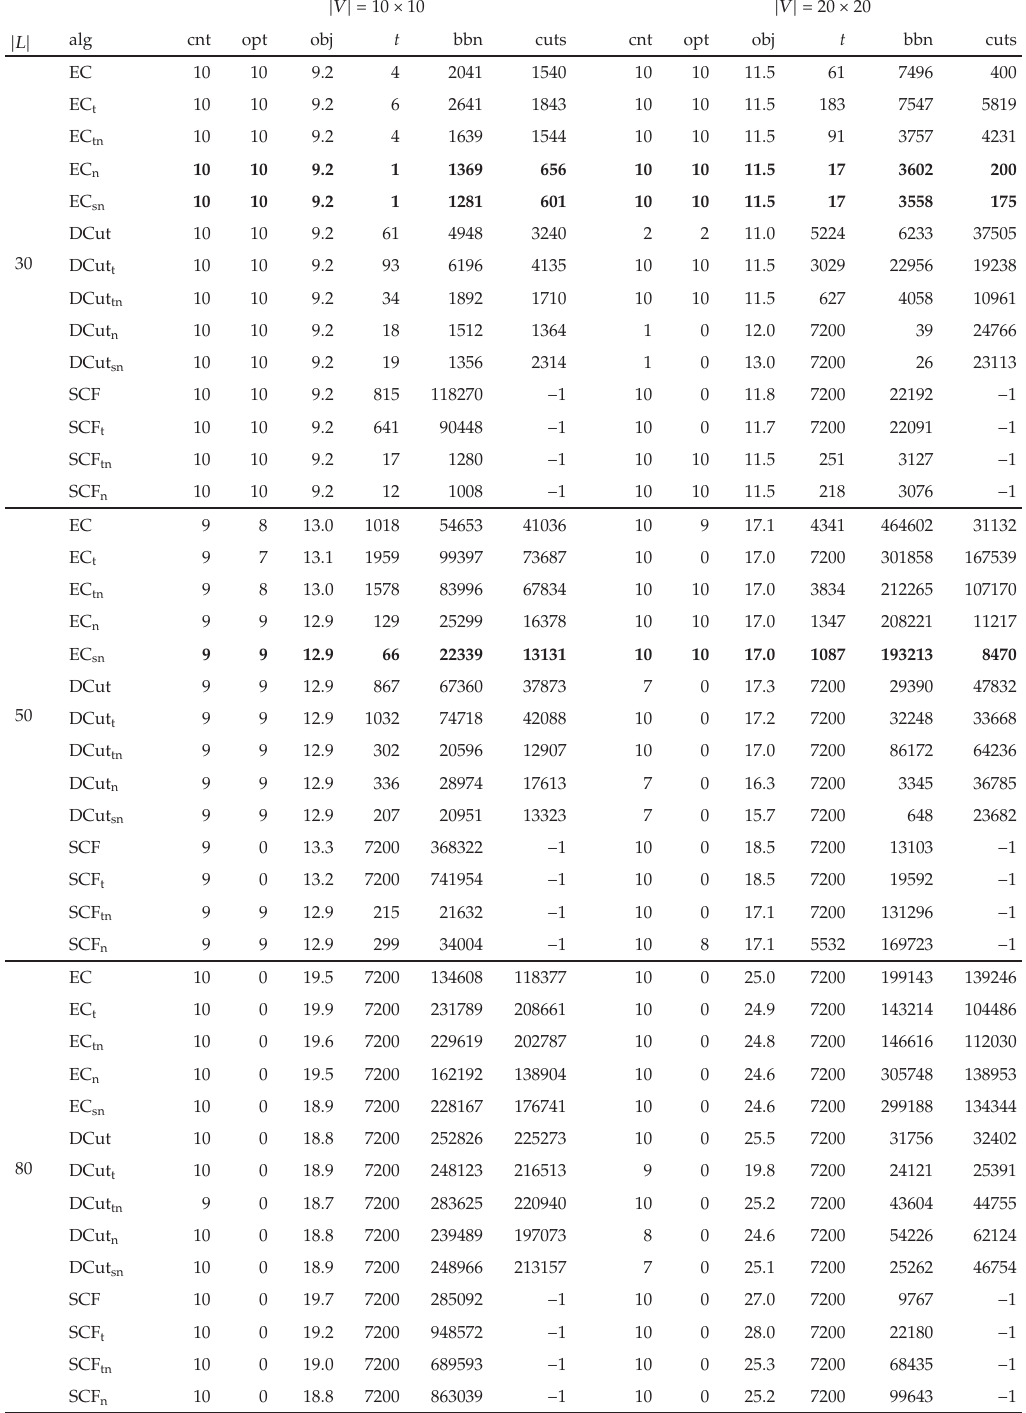
Table 7: Comparison of selected variants of formulations EC, DCut and SCF on the grid graph instances from SET-III with | E | ≈ 4 · | V |